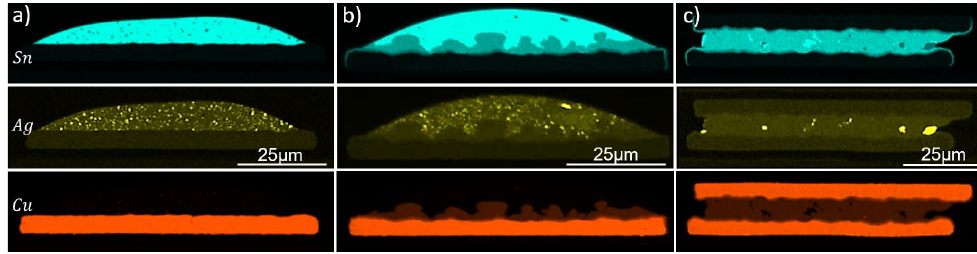
Figure 10. Sn ( top ), Ag ( middle ) and Cu ( bottom ) map after bumping ( a ), ball reflow ( b ) and module reflow ( c